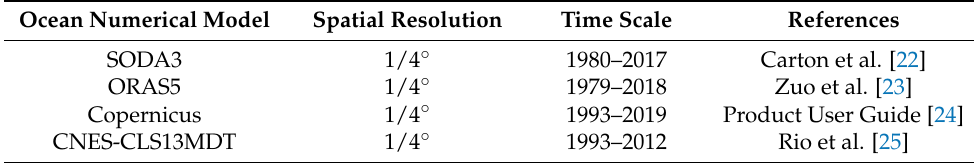
Table 2. Details of the ocean numerical models.